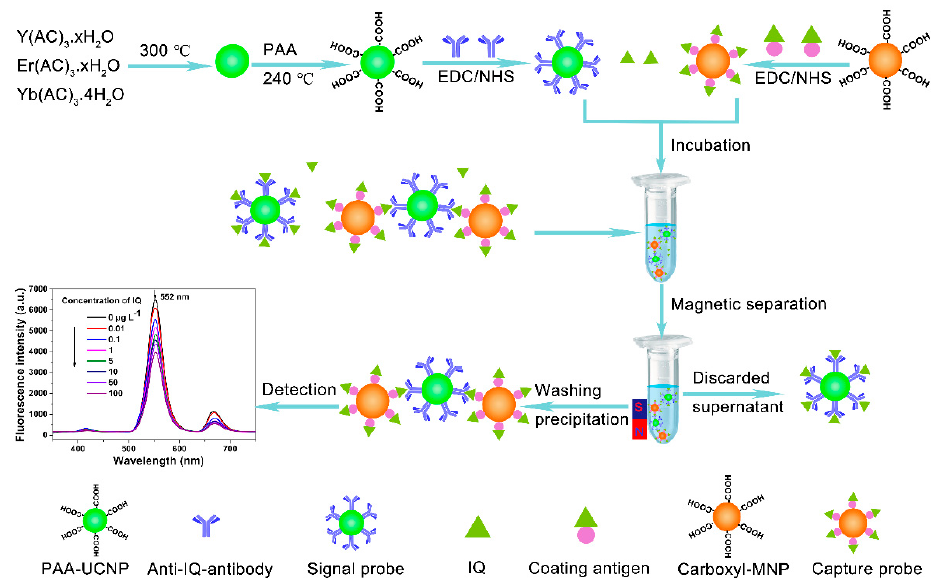
Figure 2. Preparation of signal probe and principle of fluorescence immunoassay.